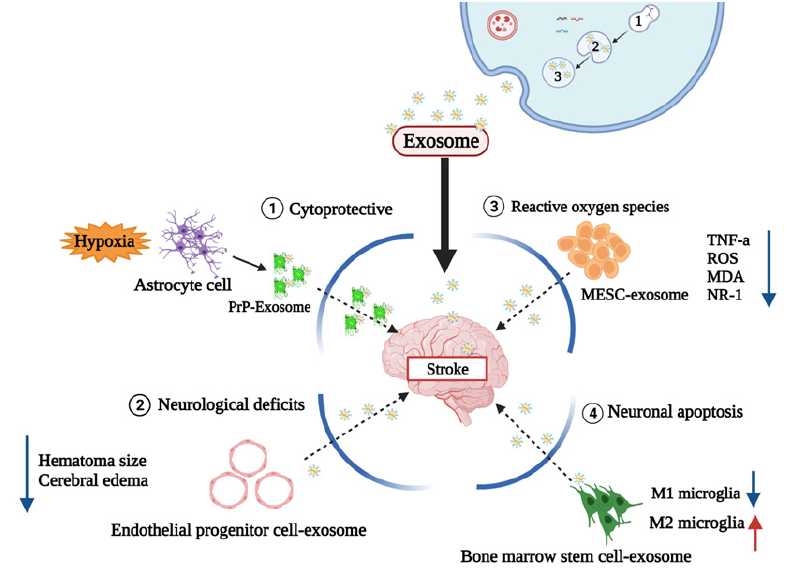
Figure 4. Therapeutic value about stroke mechanism. Mechanism of exosomes as therapeutic agents: (1) Prion proteins are associated with cell defense against hypoxia and damage caused by ischemia (2) Endotheliological progenitor cell derived exosome reduces neurologic definitions (3) Embryonic stem cell exosomes (MESC-exotic) containing curcumin reduce ROS-related genes (4) Exosomes derived from bone marrow stem cells inhibit microglia inflammation and protect microglia from inflammatory neurotoxicity.